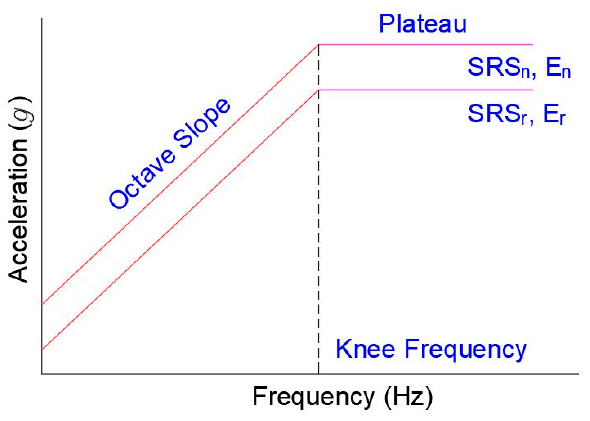
Figure 4. Energy scale change of SRS.